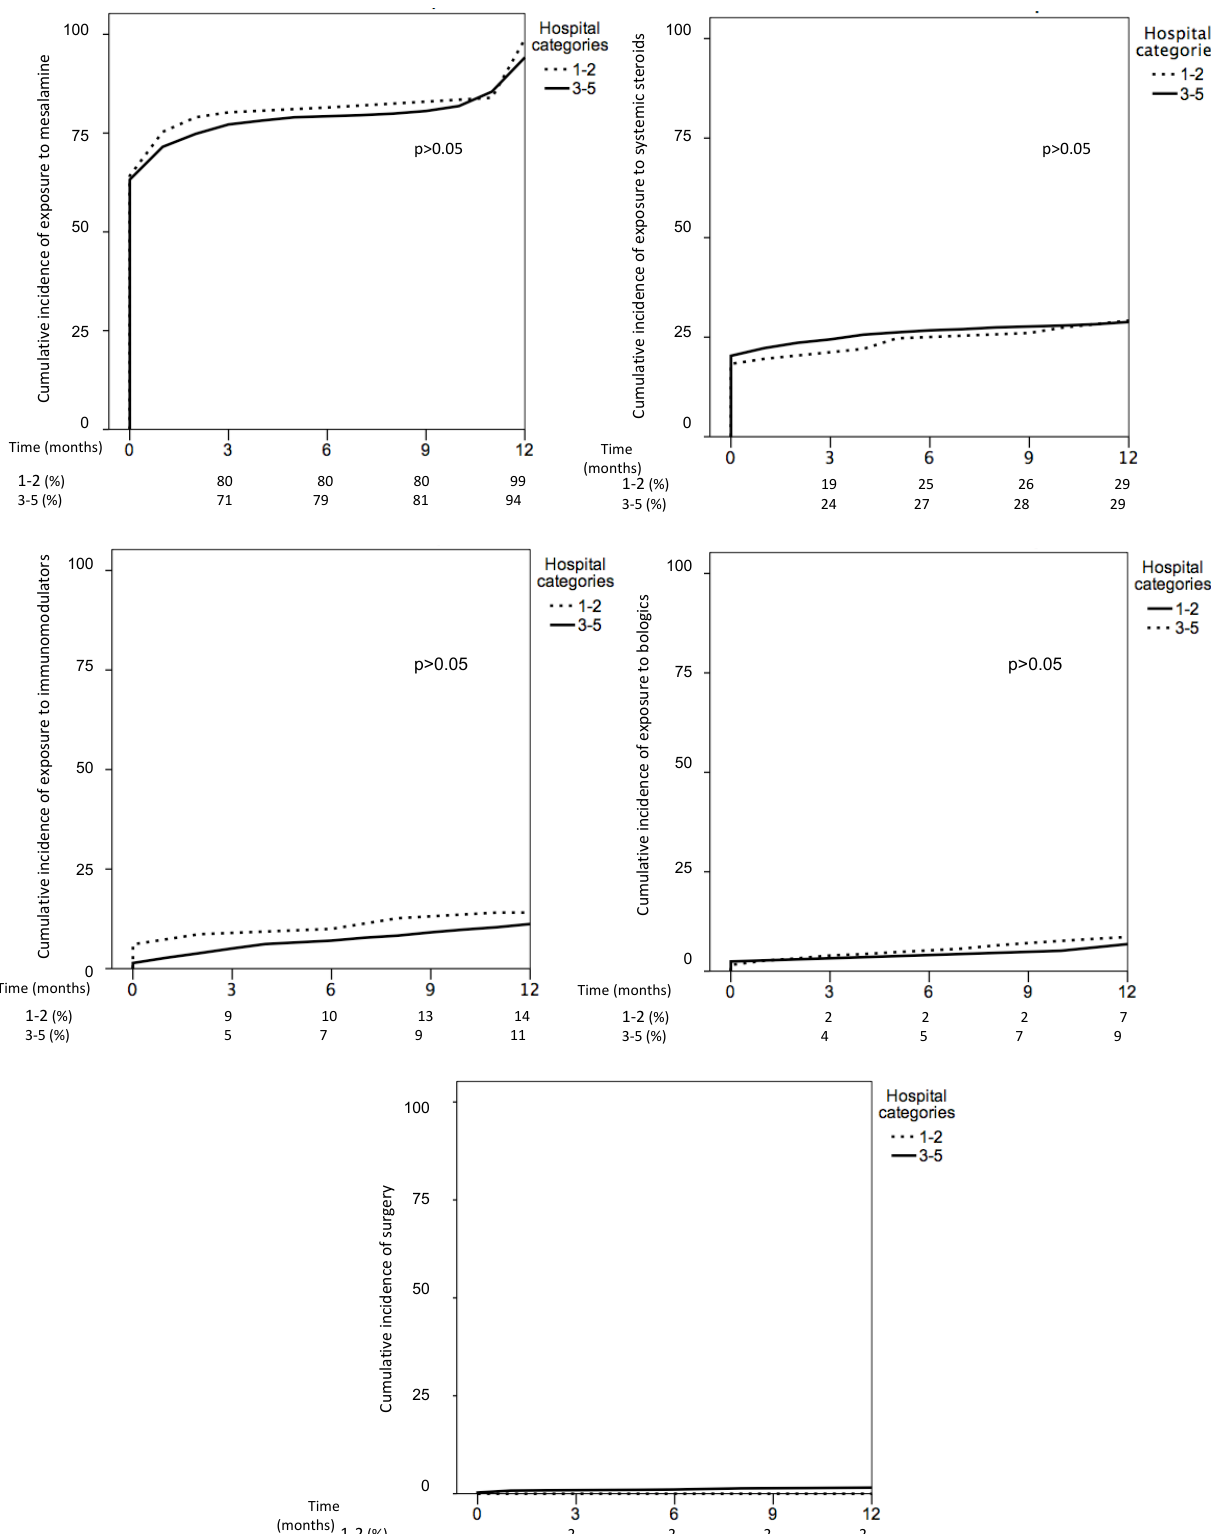
Figure 4. Cumulative incidence of exposure to treatments in ulcerative colitis based on hospital categories: low endowed (1 and 2) vs. highly endowed (3-5).